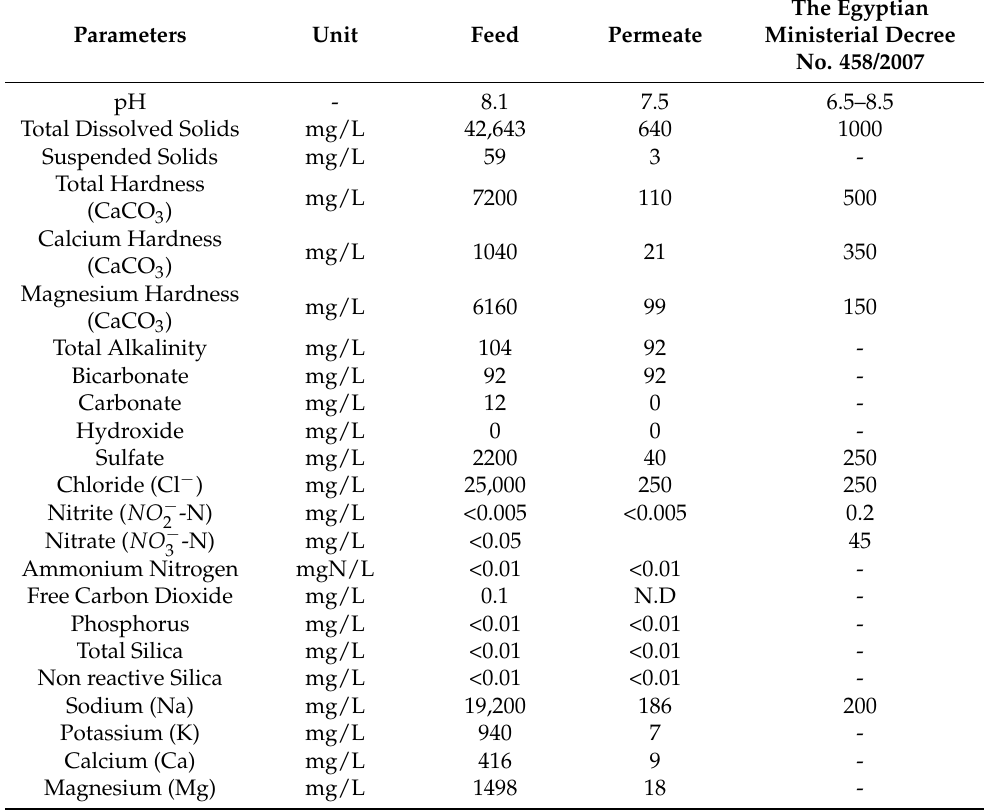
Table 9. Physico-chemical analysis for seawater and